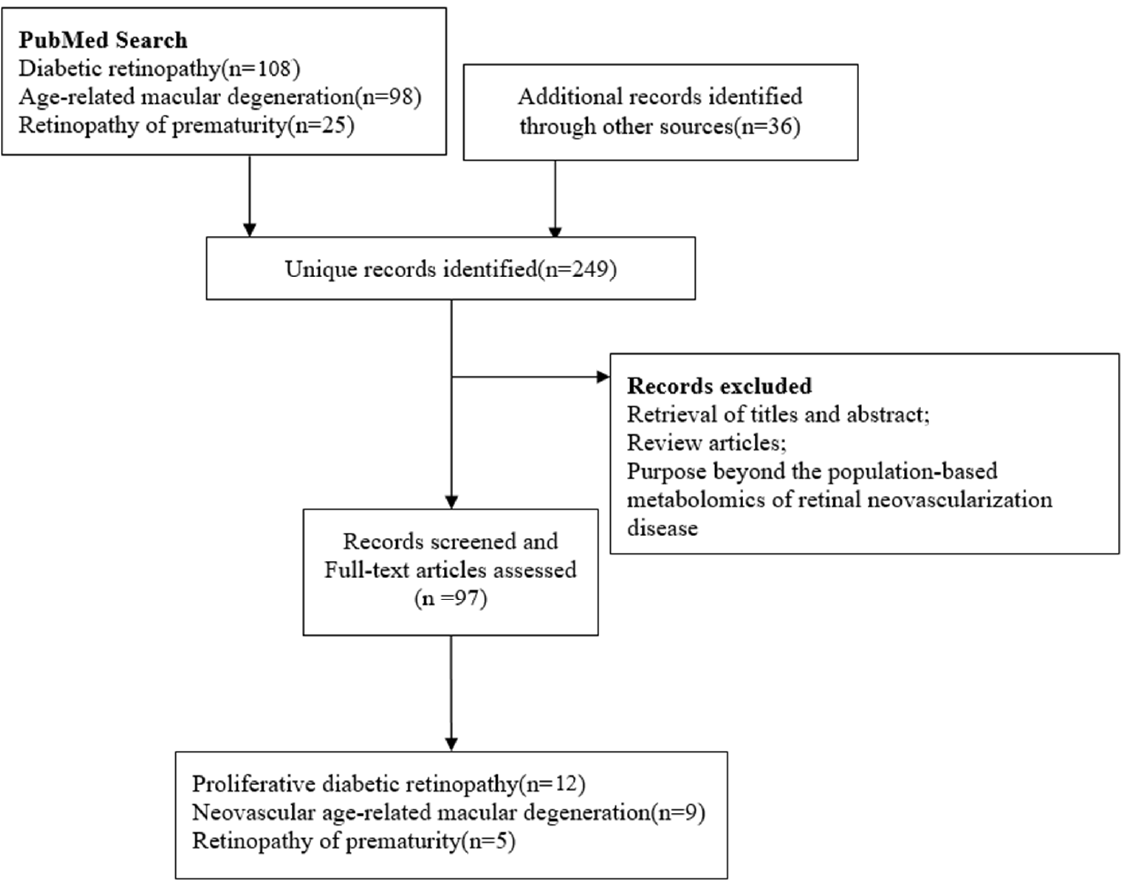
Figure 1. Flow diagram of literature search and study selection for metabolite markers of retinal neovascularization disease.